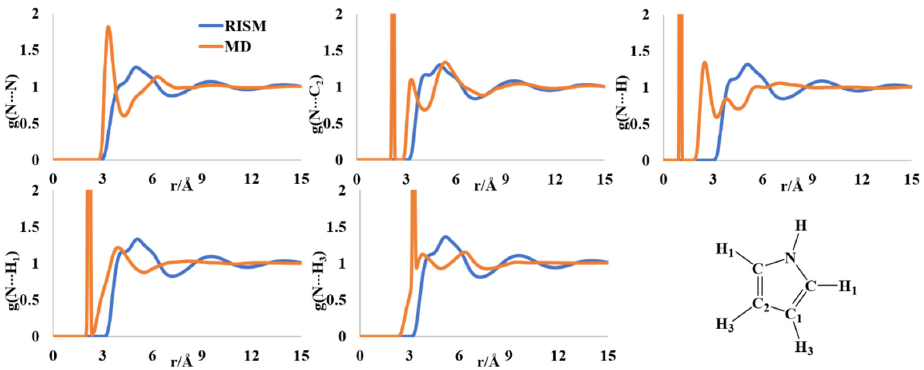
Figure 2. RISM- and MD-computed distribution functions for liquid